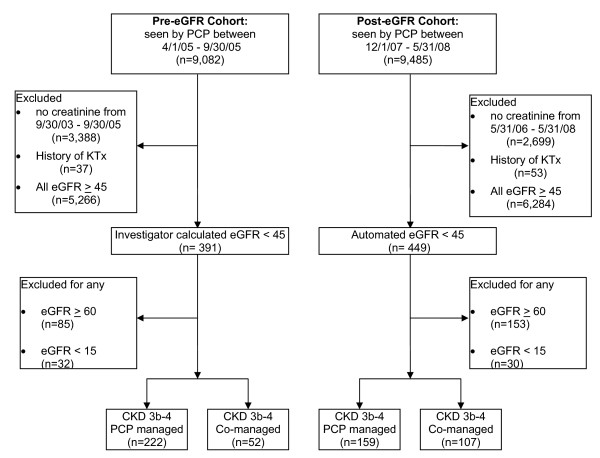
Patient selection.eGFR estimated glomerular filtration rate, KTx kidney transplant, CKD chronic kidney disease,PCP primary care physician.